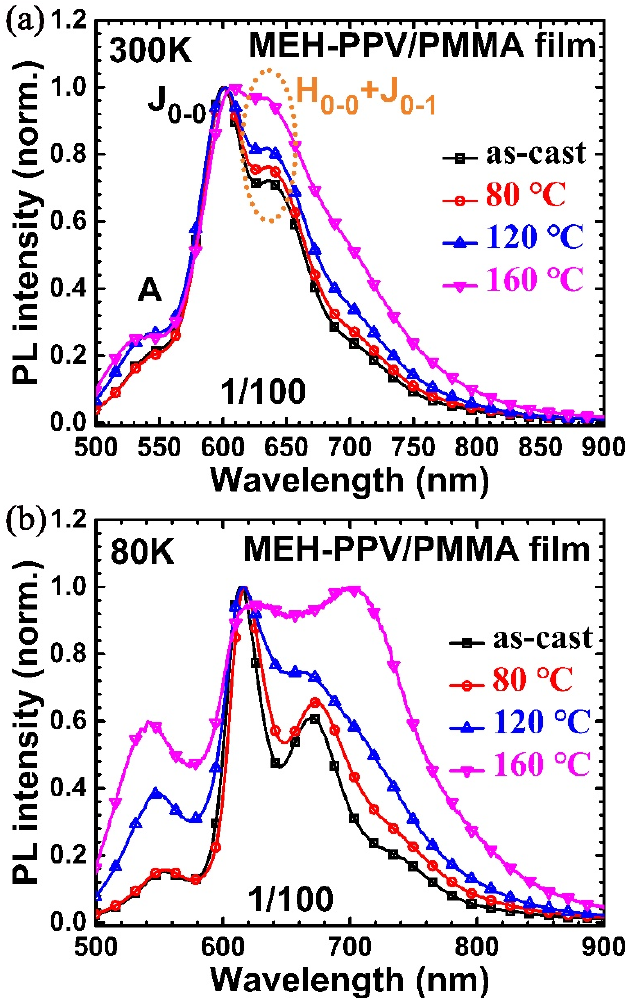
Figure 4. Photoluminescence spectra measured at 300 K ( a ) and 80 K ( b ) of MEH-PPV/PMMA (1/100) films of as-cast and annealed using various temperatures (80, 120, 160 °C).